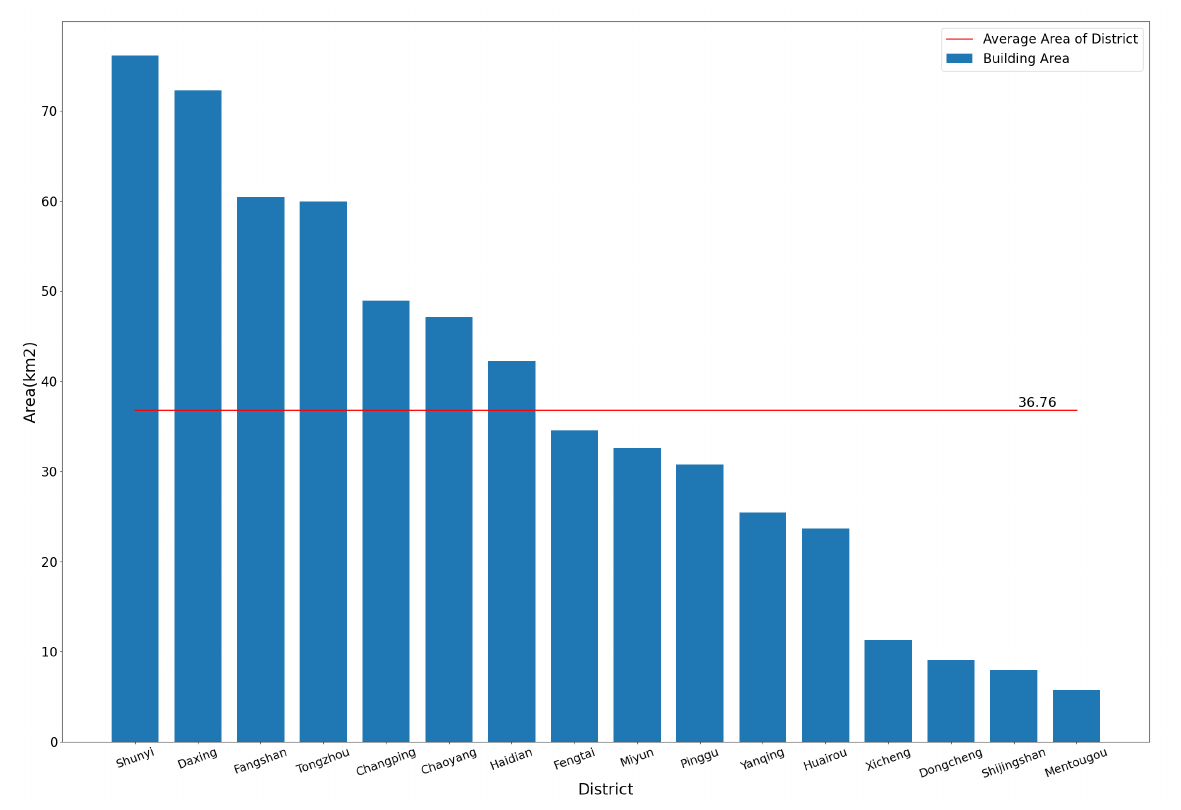
Figure 9. Building area of each district in